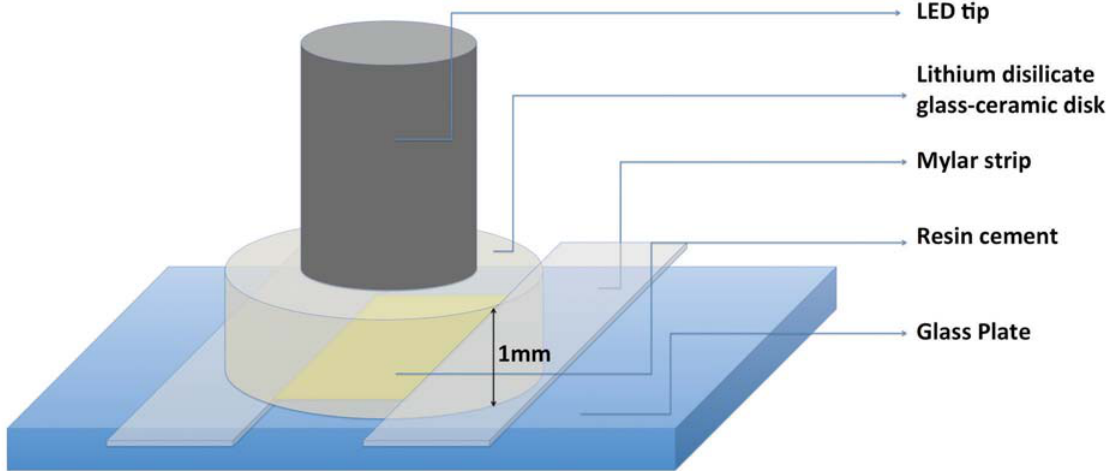
Figure 2- Experimental set